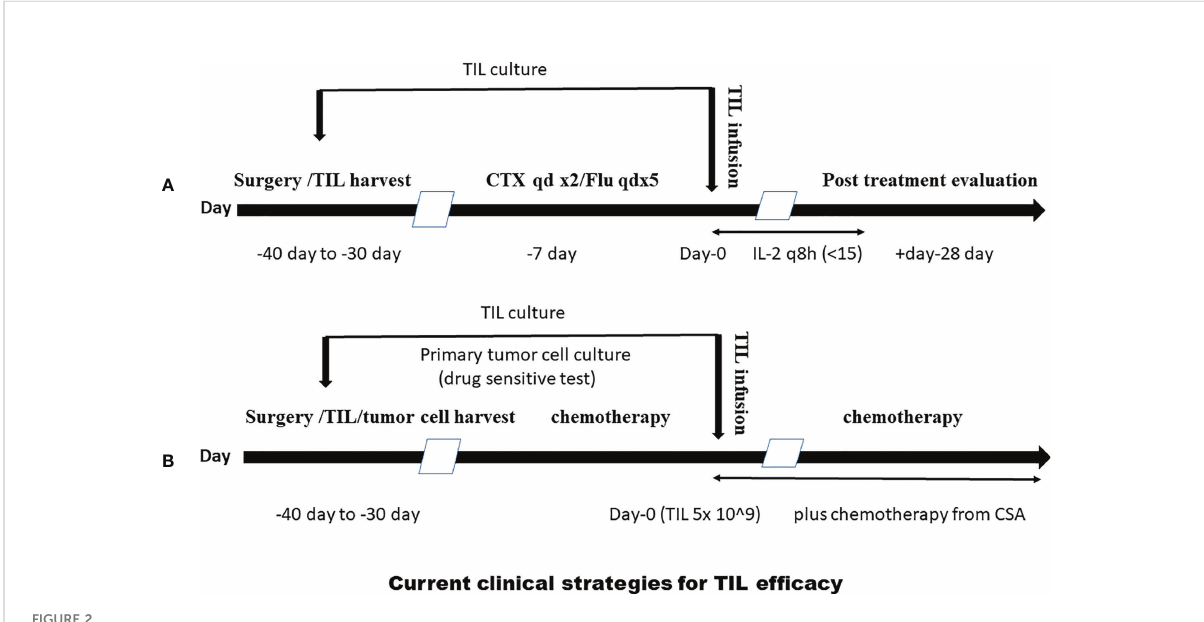
FIGURE 2 Clinical strategies for TIL ef fi cacy. (A) A lympho-depleting regimen adding TIL treatment to increase TIL ef fi cacy. (B) A clinical procedure combining TILs with sensitive chemotherapeutic agents, which were screened using chemo-sensitivity assay (CSA) from TIL cytotoxicity experiment of patients ’ autogenous tumor cell to increase treatment